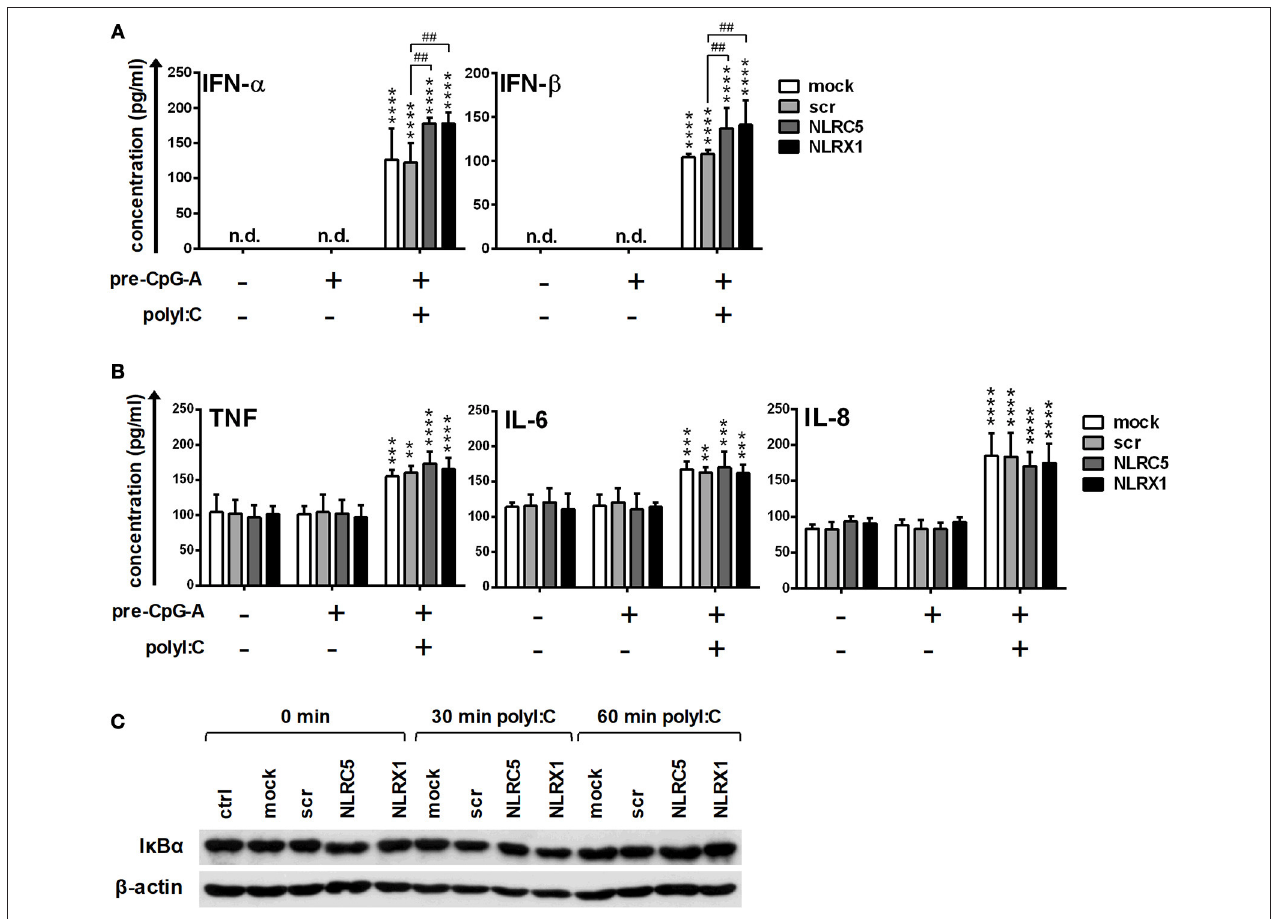
FIGURE 4 | The RIG-I/MDA5 agonist-induced type I IFN production is upregulated by NLRC5 or NLRX1 silencing while the NF- κ B signaling pathway is not affected in GEN2.2 cells. (A–C) Cells were transfected with siRNAs specific for NLRC5, NLRX1 or scrambled (scr) siRNAs for 24h then pre-treated with 0.25 µ M CpG-A (pre-CpG-A) for 16h to induce the cytosolic expression of RLRs. Following thorough washing steps cells were stimulated with the RIG-I/MDA5 agonist polyI:C (1 µ g/ml). The protein levels of IFN- α , IFN- β ( A ), TNF, IL-6, and IL-8 (B) were measured by ELISA after 6 (A) or 24h (B) . (C) Kinetics of I κ B α degradation was determined by western blotting. (C) A representative blot is shown. Data are represented as means ± SD of 4 individual experiments and analyzed using one-way ANOVA followed by Bonferroni’s post-hoc test. ** p < 0.01, *** p < 0.0001, **** p < 0.0001 vs. pre-CpG-A-treated samples; ## p < 0.01, n.d., not